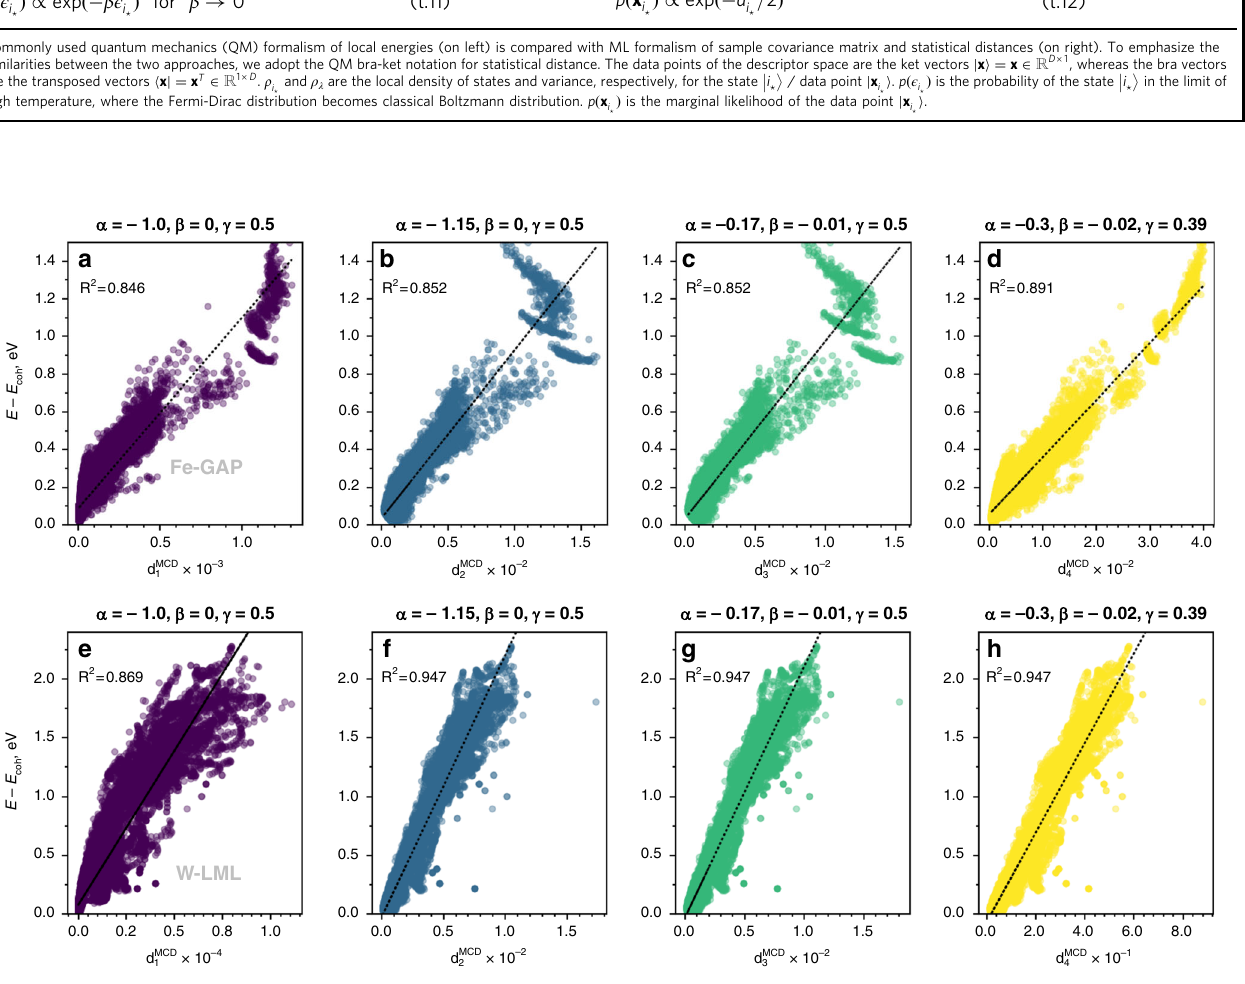
Fig. 9 Correlation of the local energy with various statistical distances. Correlation with the local energy from ( a – d ) GAP interatomic potential for Fe and ( e – h ) linear ML (LML) interatomic potential for W. The subplots ( a , e ) illustrate the standard MCD/Hotteling ’ s T 2 estimator; ( b – d ) and ( f – h ) correspond to the variations of statistical distances inspired by